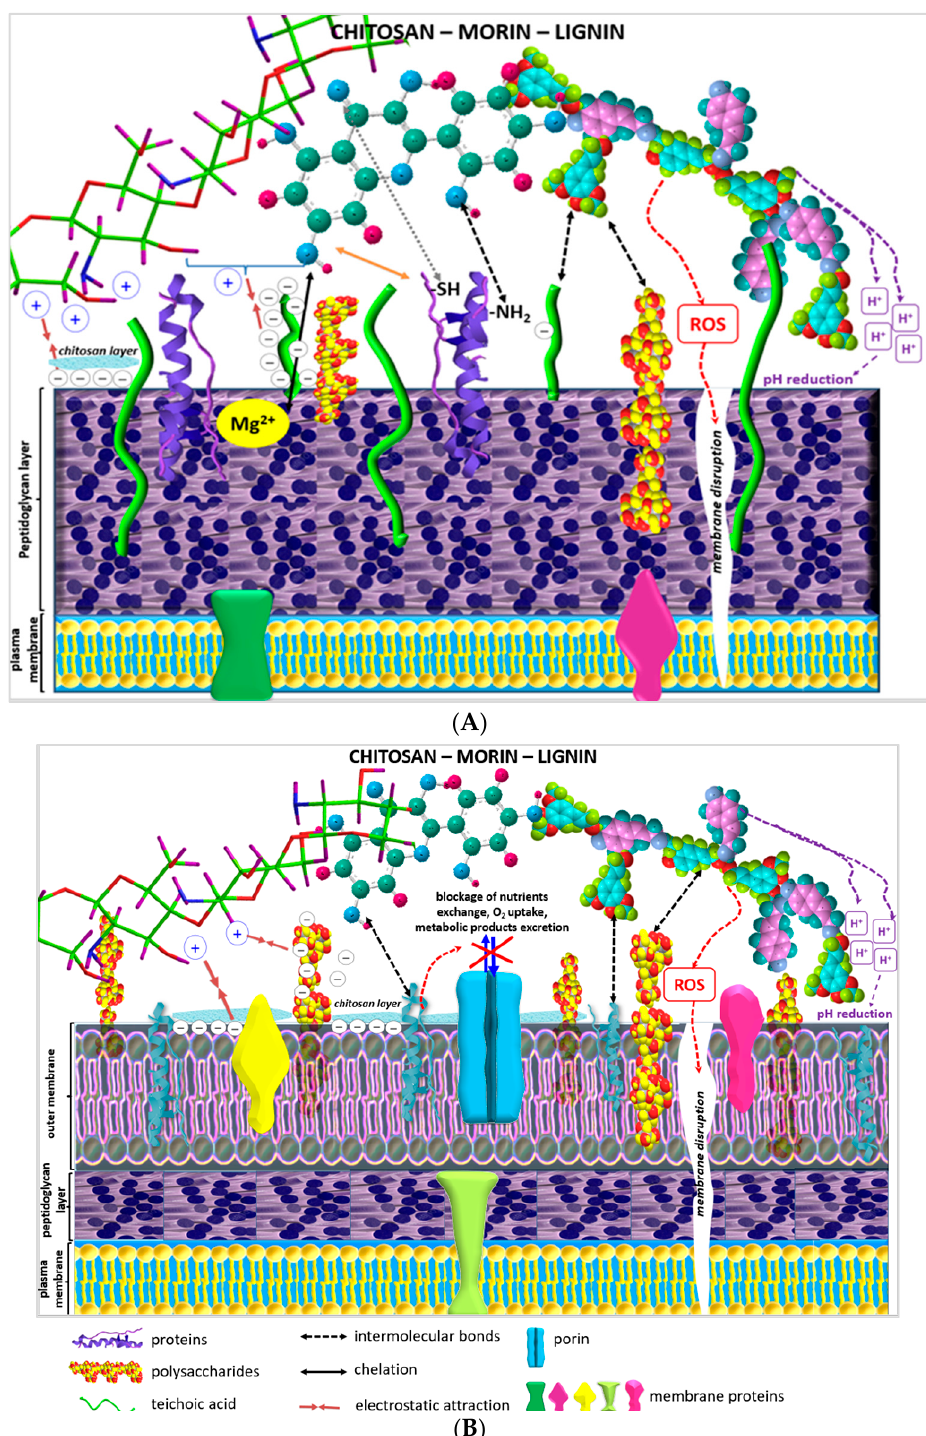
Figure 6. Schematic representation of the postulated antimicrobial activity mechanisms of the stud- ied two- and three-component morin–chitosan–lignin combined systems against: ( A ) Gram-positive and ( B ) Gram-negative bacteria.